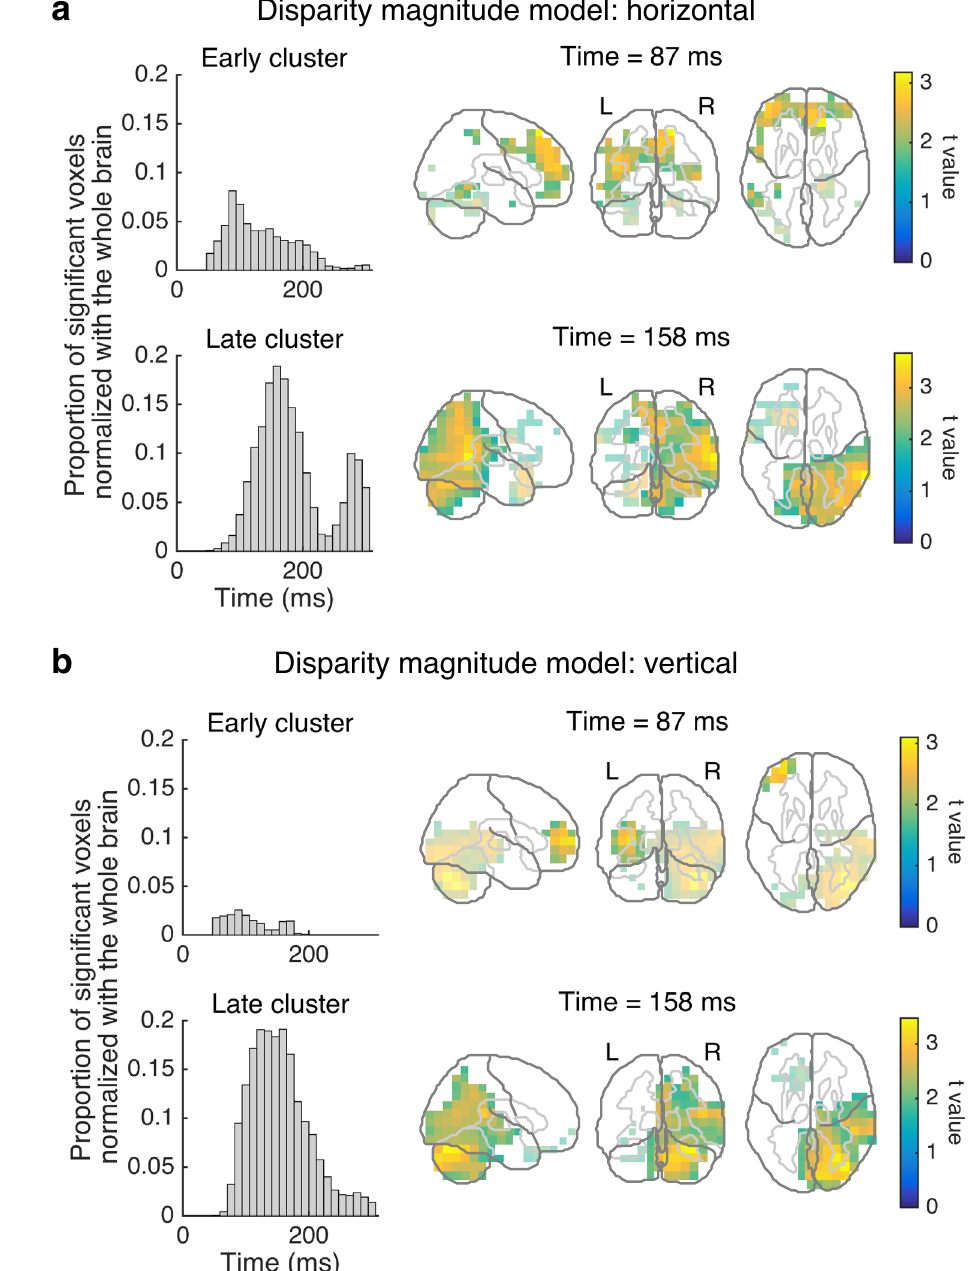
Figure 3. Large-scale neural sensitivity to disparity magnitude. ( a ) The horizontal condition. ( b ) The vertical condition. In each of ( a ) and ( b ), the left two histograms show the early- and late-peak subclusters of the significant voxels showing a positive sensitivity to disparity magnitude ( p < 0.05, corrected). The right two panels show snapshots of the corresponding cluster in the frontal (top), temporal, occipital, and cerebellar (bottom) areas. The most significant voxels are mapped onto three planes. Light-colored voxels represent the other subcluster (i.e., the late-peak subcluster in the top-right panel and vice